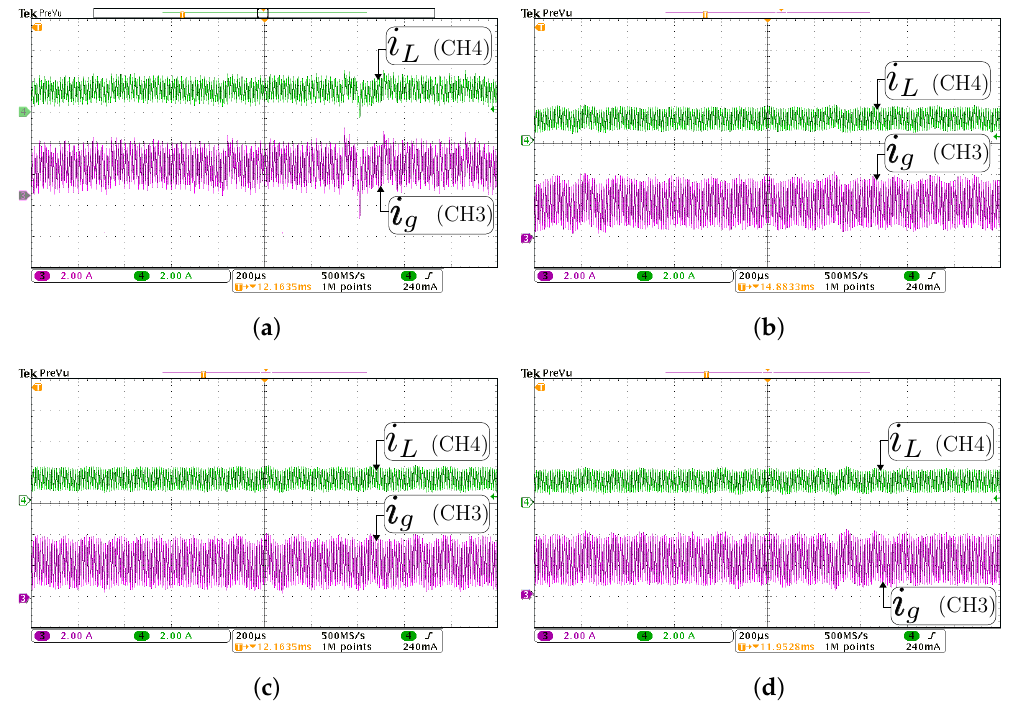
Figure 8. Time domain waveforms of i g and i L : ( a ) Test 1, ( b ) Test 2, ( c ) Test 3, ( d ) Test 4. CH3: i g (2 A/div), CH4: i L (2 A/div), and time base of 200 µ